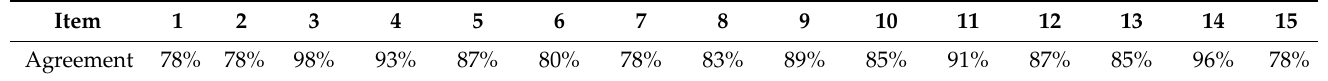
Table 5. Usability assessment design.